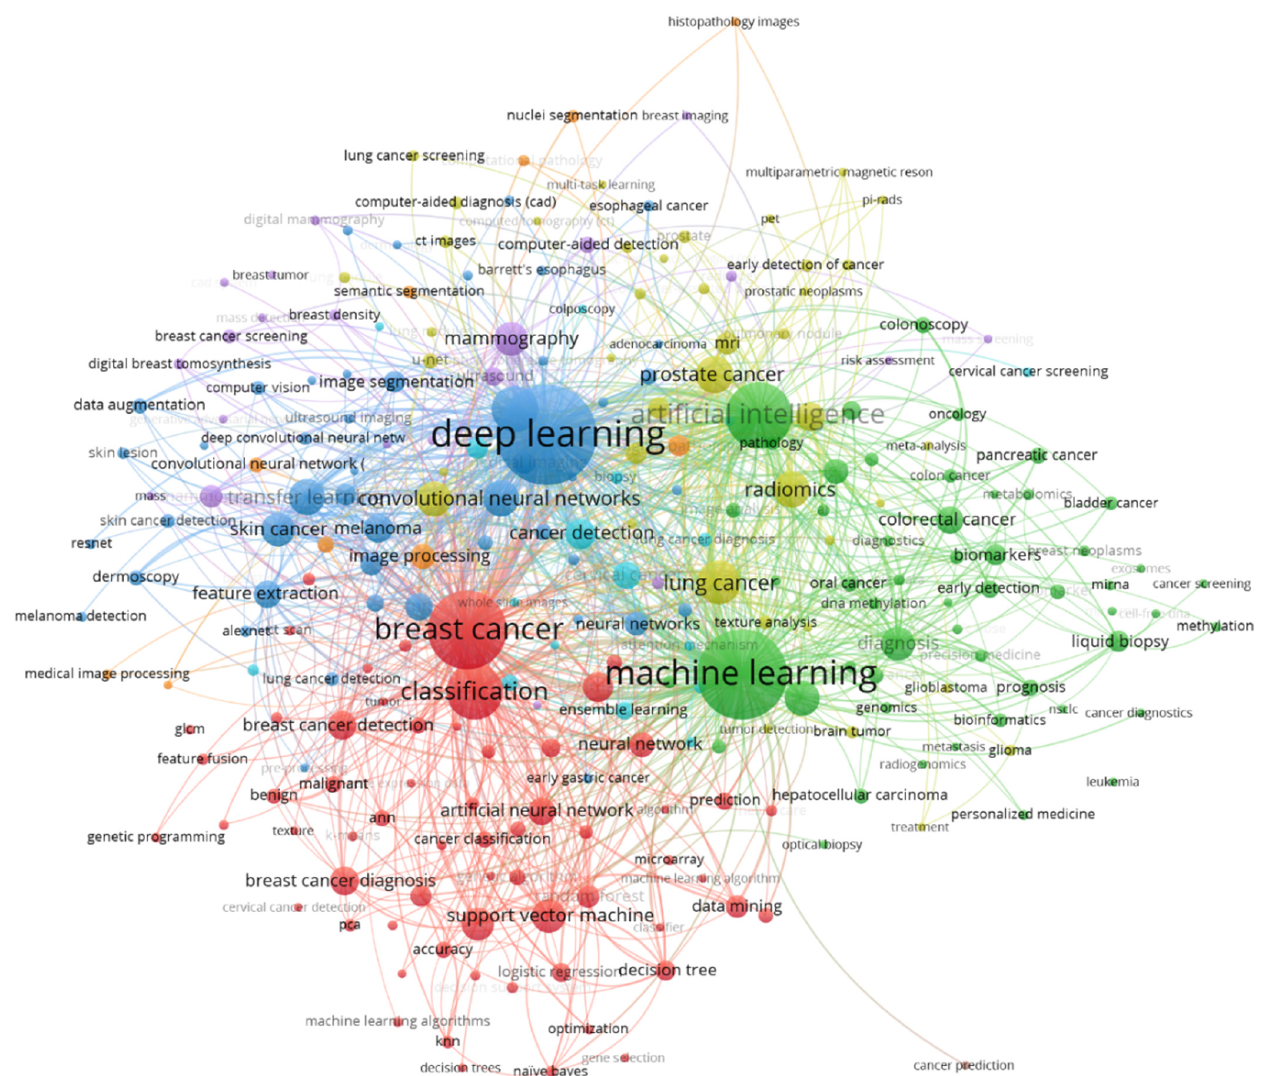
Figure 6. Network of keyword co-occurences.